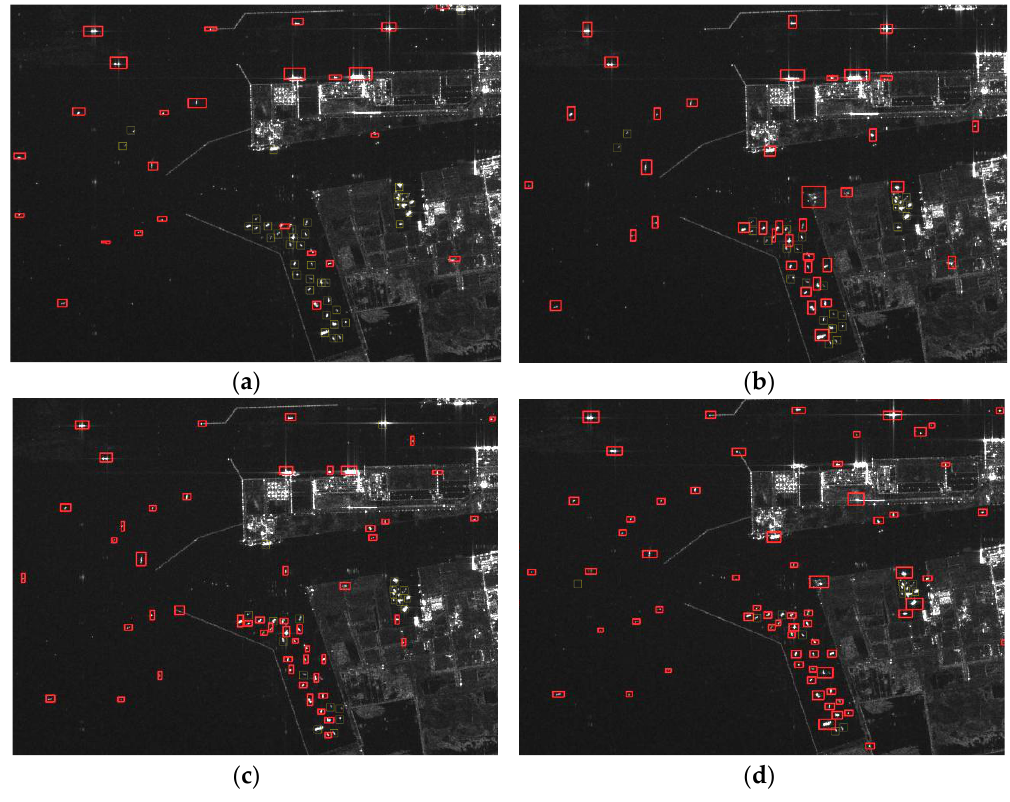
Figure 6. The comparisons of detection results with different layer combination strategies. The red and yellow rectangles represent the detection results and missing ships of detectors respectively. ( a ) conv5; ( b ) conv 3+4+5; ( c ) conv 1+3+5; ( d ) conv